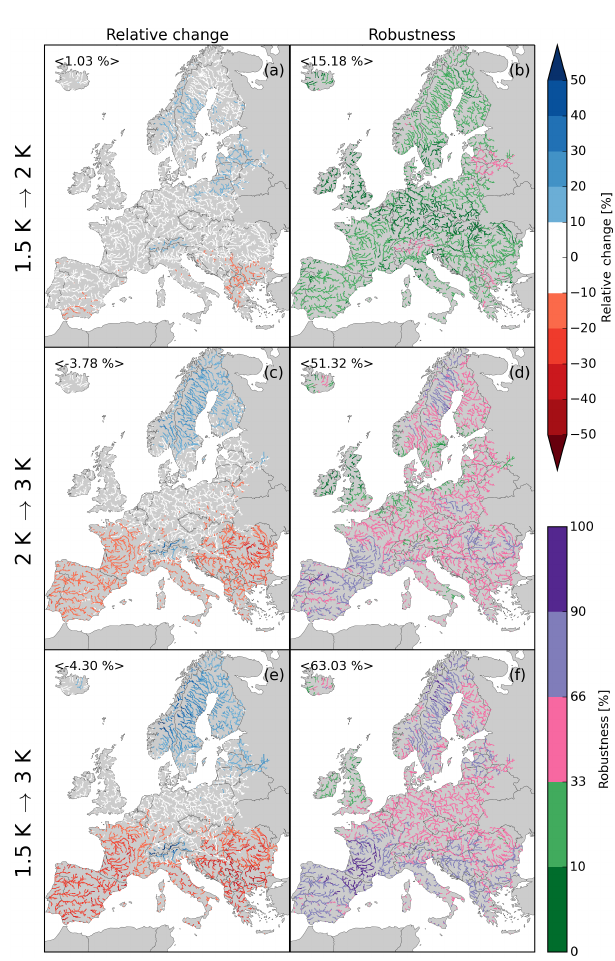
Figure 5. Relative change (%) in multi-model ensemble median Q90 between different levels of warming (a, c, e) and robustness of the signal between those (b, d, f) . The latter is expressed by the percentage of simulations based on a Wilcoxon rank-sum test with 5% significance level. The values given in the upper left of the sub- plots are the continental average along the river network for all grid cells with a contributing area greater than 1000km 2